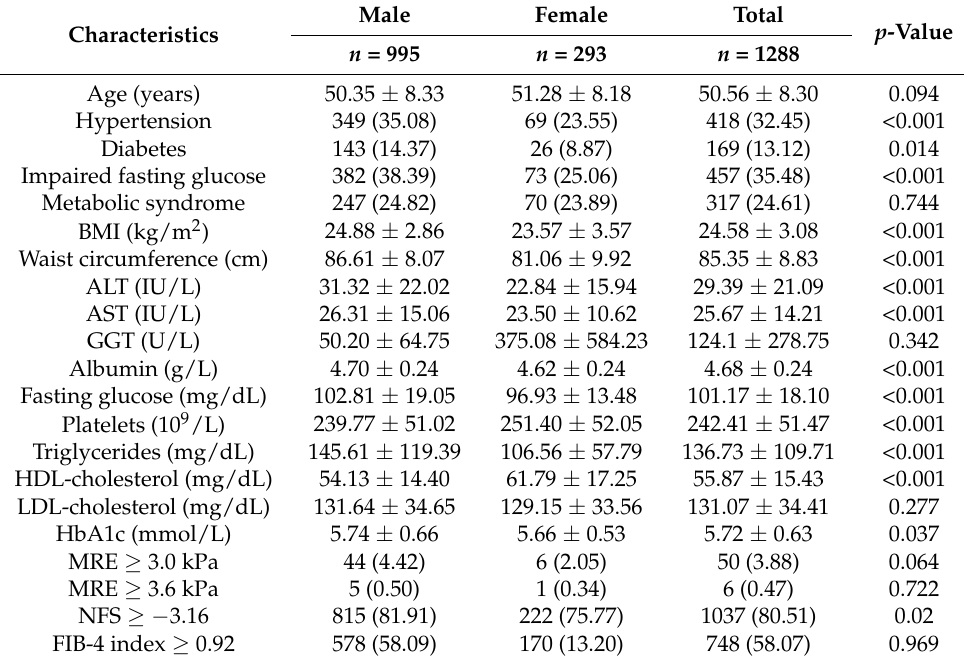
Table 1. Baseline